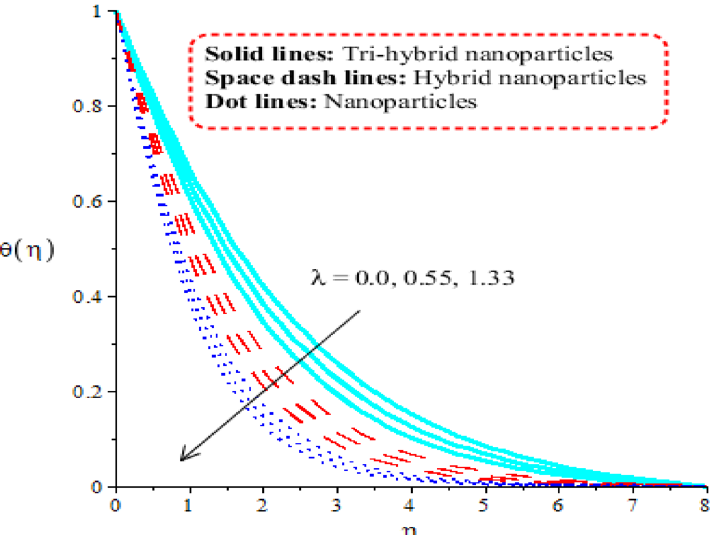
Figure 7. Distribution in θ(η) against (cid:31) .